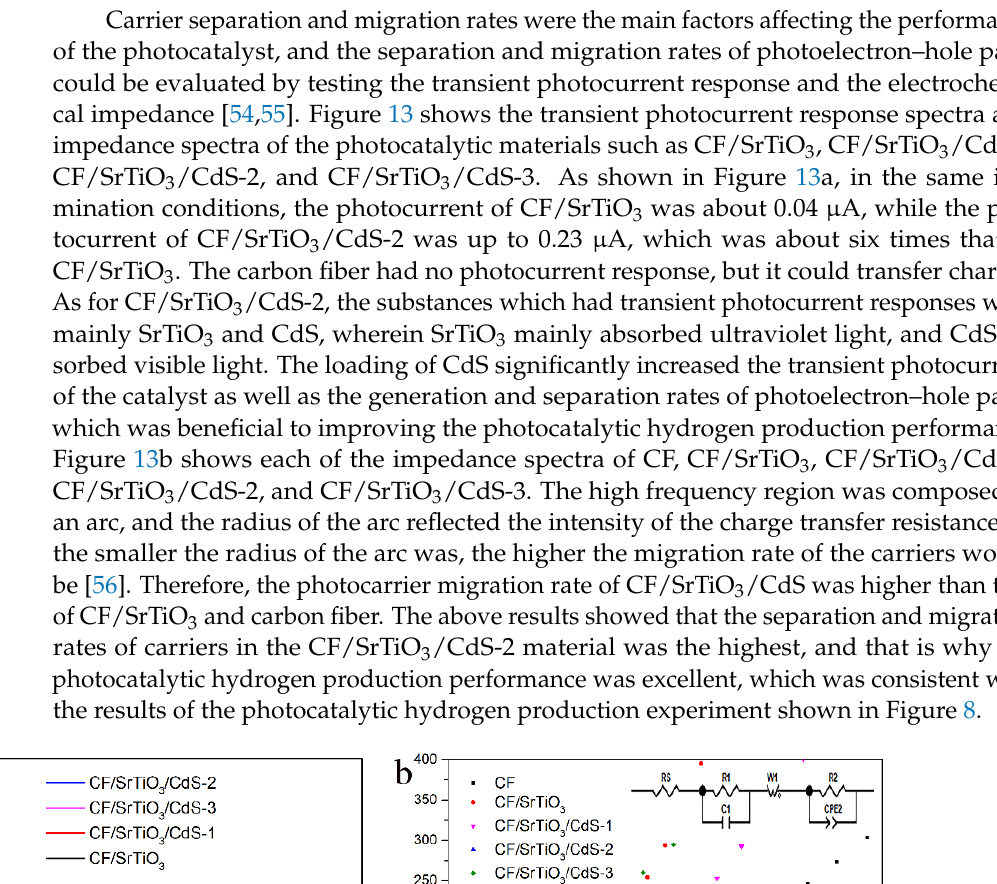
Figure 12. Mott–Schottky plots of samples: ( a ) SrTiO 3 and ( b ) CdS.